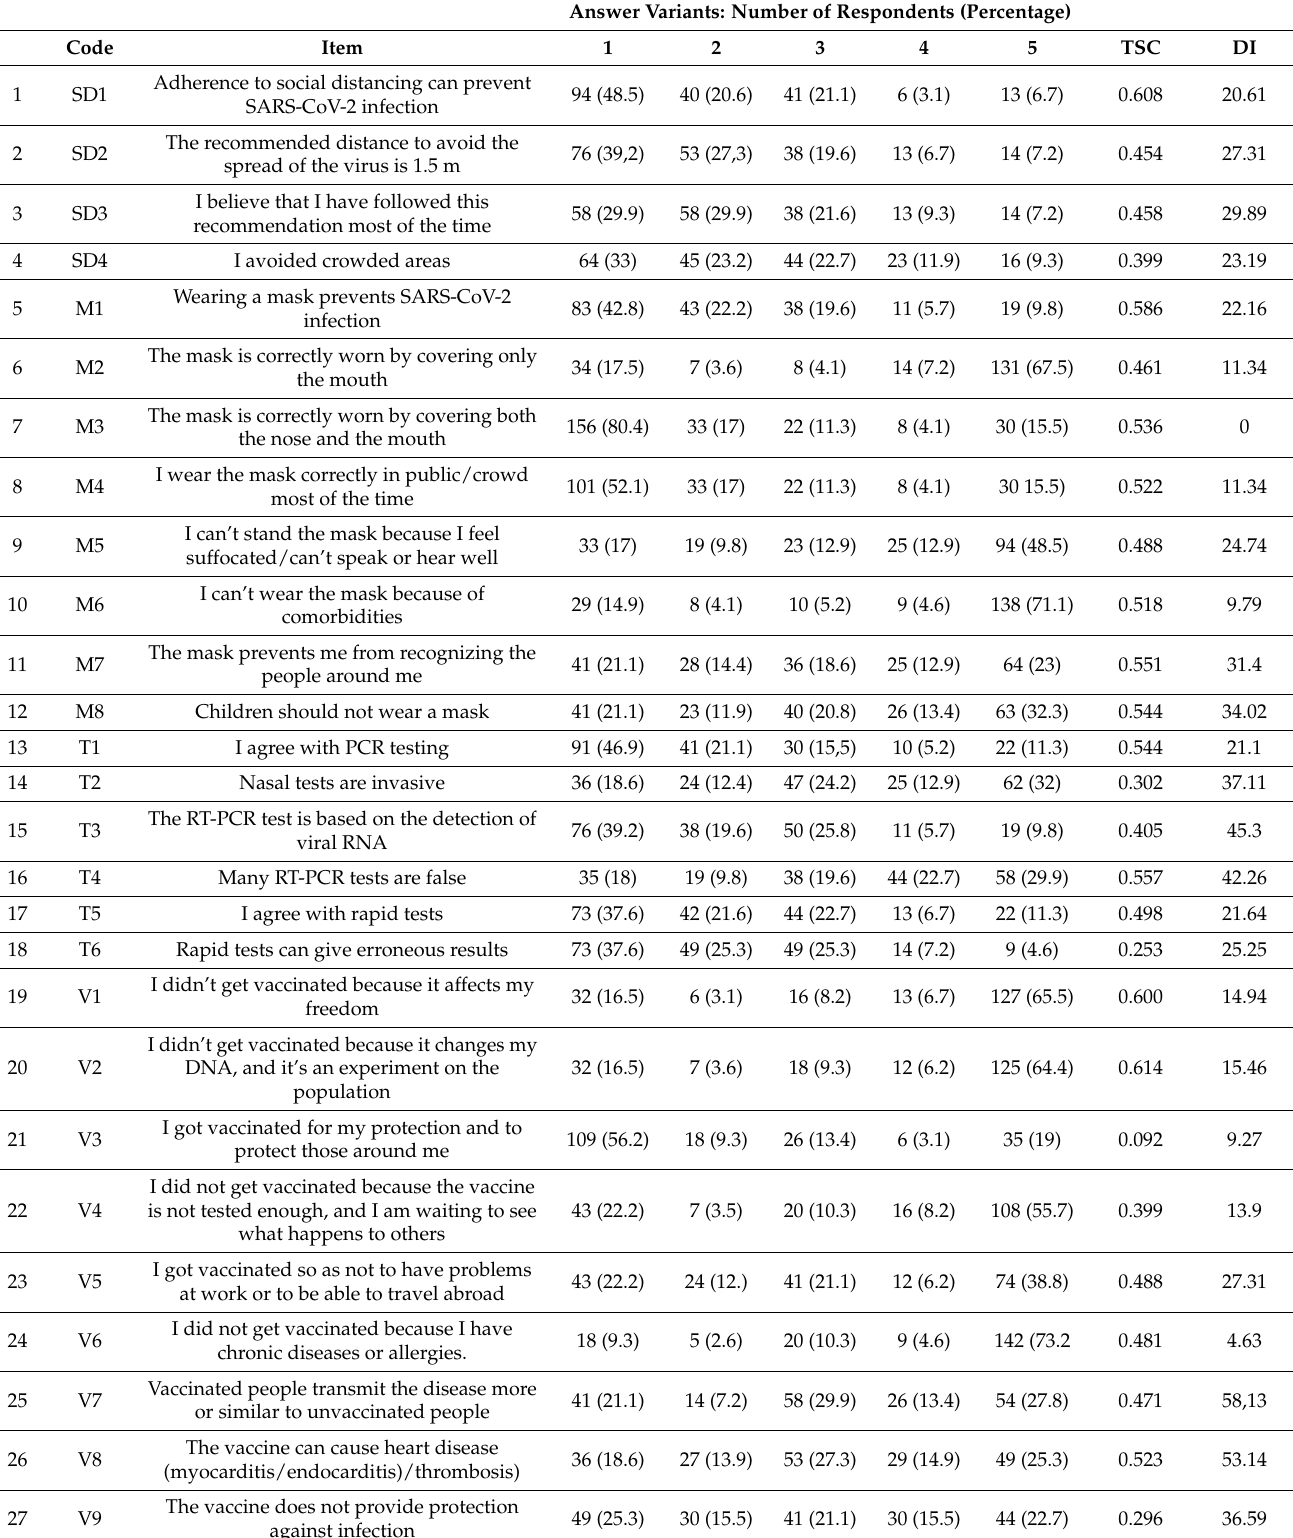
Table 2. First version of the